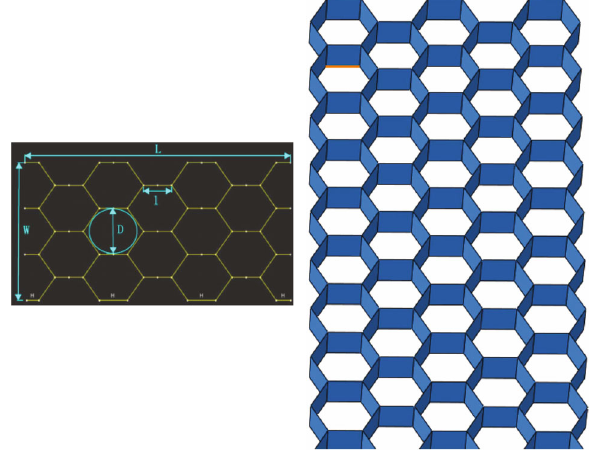
Figure 3: ABAQUS cellular model automatic modeling plug-in.